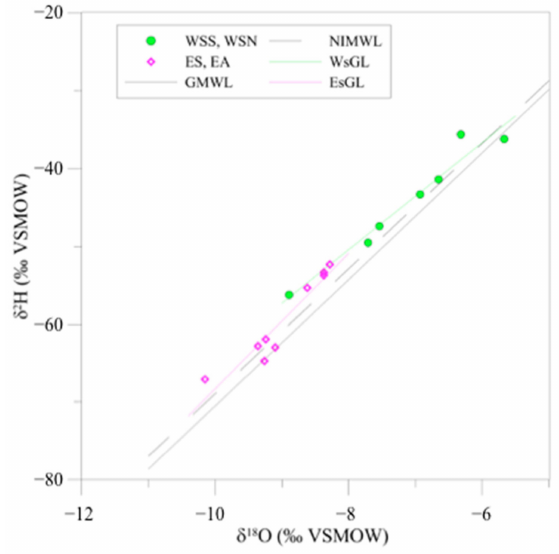
Figure 6. Plot of deuterium versus oxygen-18 for the investigated springs. The global meteoric water line [10] and the Northern Italy water line [4] are also reported. EsGL: Eastern side Groundwater Line; WsGL: Western side Groundwater